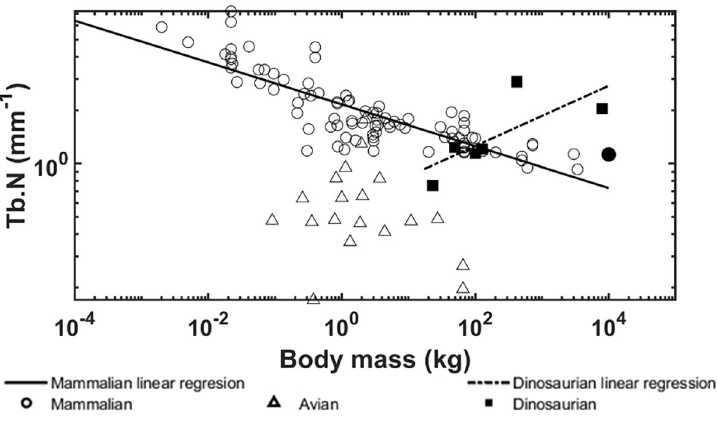
Fig 9. Logarithmically scaled plots of the trabecular number (Tb.N) versus body mass. Pairwise comparisons indicate the dinosaur regression slope is different from the mammalian (p < 0.001) and avian (p = 0.004) slopes. The solid circle indicates the